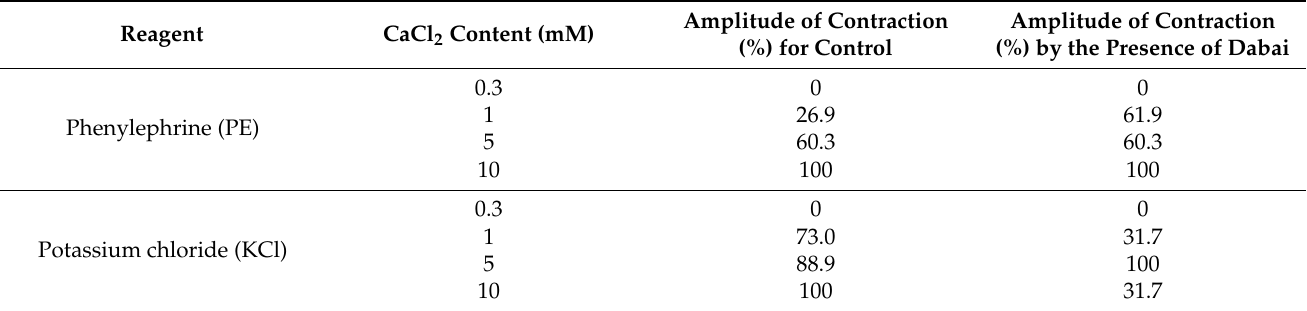
Table 2. Effect of the CaCl 2 content and type of reagent on the amplitude of